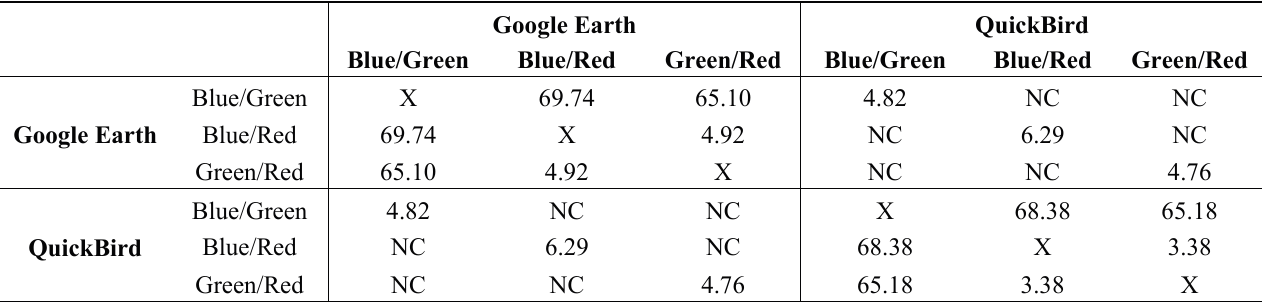
Table 2. Compilation of the Z -values between the three Digital Relative Depth Models with respect to the Google Earth-derived very high resolution mosaic and pansharpened QuickBird imagery. Google Earth